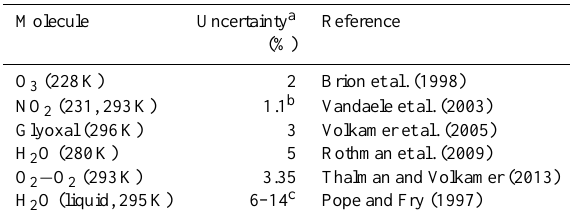
Table 1. Reference cross sections used in this study. Molecule Uncertainty